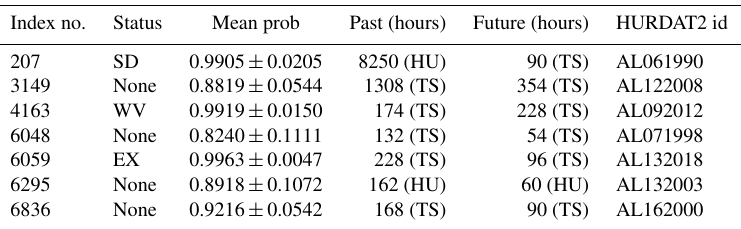
Table A7. Background images wrongly classified as TC-containing images (false positives) for all combinations of training/testing datasets. For each image we also indicate the status of the image according to HURDAT2 if present in the database (“None” if not present), the probability of the classification (with its standard deviation across the combinations of training/testing datasets), and the temporal distance to a cyclone in the past and in the future (with the status of the cyclone).